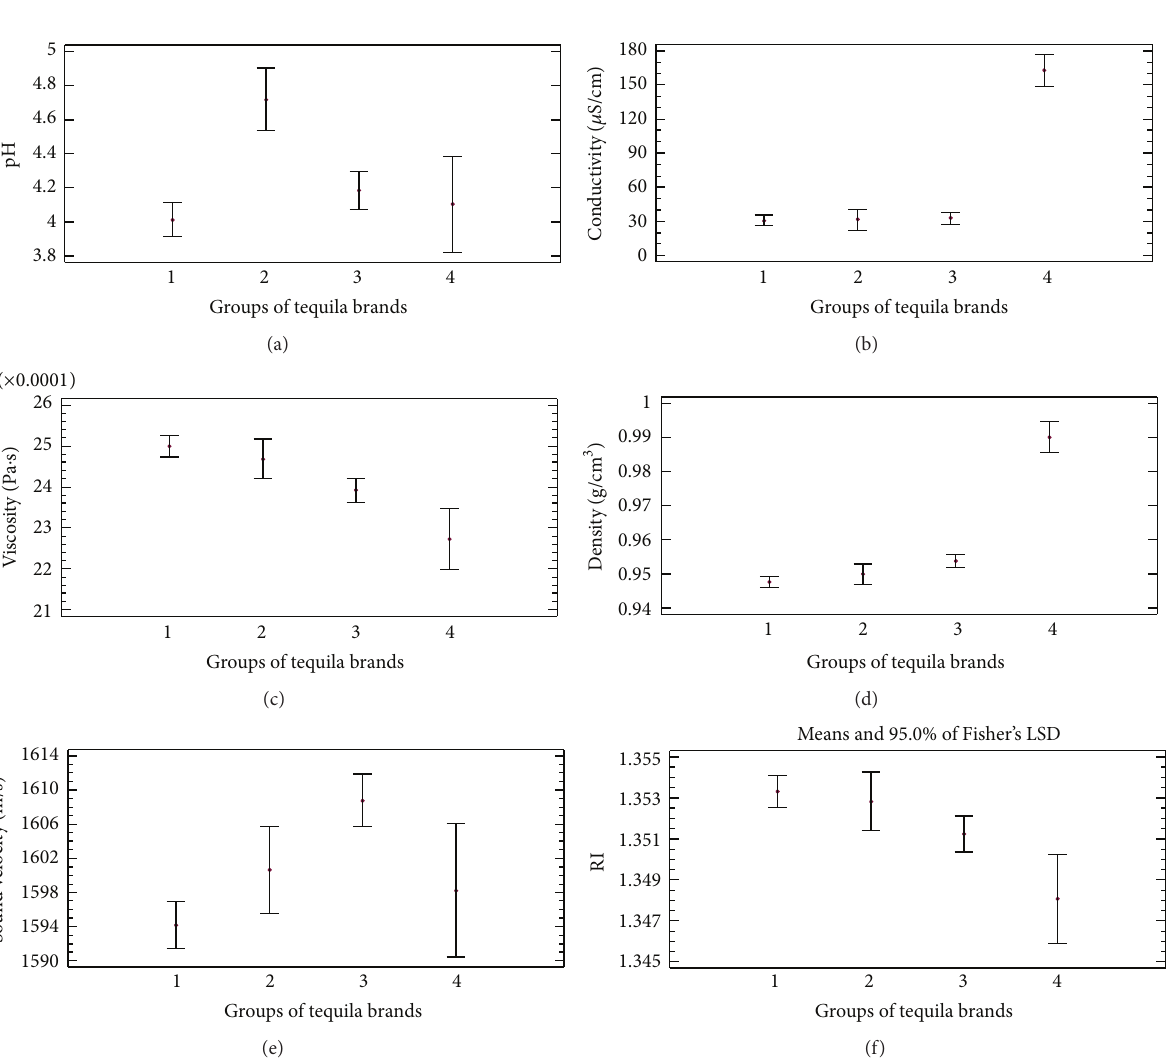
Figure 3: Means graphs obtained by the method of Fisher’s LSD from cluster analysis: (a) pH, (b) conductivity, (c) viscosity, (d) density, (e) sound velocity, and (f)